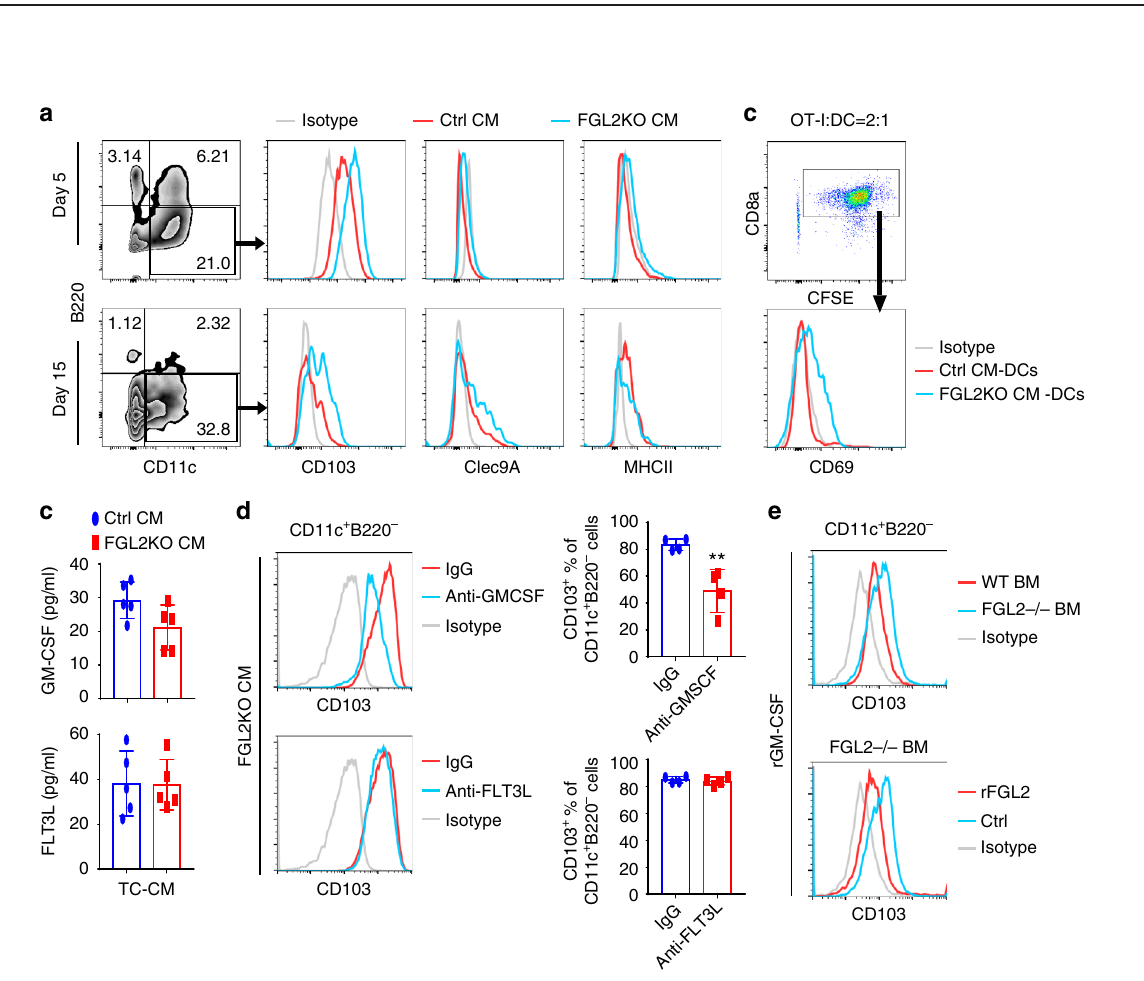
Fig. 5 FGL2 suppresses GM-CSF-dependent CD103 induction on cDCs in vitro. a Expression of CD103 on CD11c + B220 − DCs cultured with conditioned medium (CM) for 5 or 15 days. Bone marrow cells were isolated from C57BL/6 mice and then cultured with Ctrl -CM (CM from Ctrl tumor cells) or FGL2KO -CM (CM from FGL2KO tumor cells) for 5 days or 15 days. Non-adherent cells were recovered, stained, and analyzed by FACS to determine the expression levels of CD103, Clec9A, and MHCII on the CD11c + B220 − DCs. b OT-I T cell activation by OVA-pulsed CM-cultured bone marrow DCs. Non- adherent bone marrow DCs were recovered from CM-cultured bone marrow DCs at 15 days. The bone marrow DCs (2 × 10 4 ) were incubated with soluble OVA protein (100 μ g/mL) for 2 h and then washed twice before co-culturing with the CFSE-labeled OT-I cells (5 × 10 4 ). OT-I activation was measured by CD69 expression level, which was determined by fl ow cytometry. c Protein levels of GM-CSF and FLT3L in medium conditioned by tumor cells were